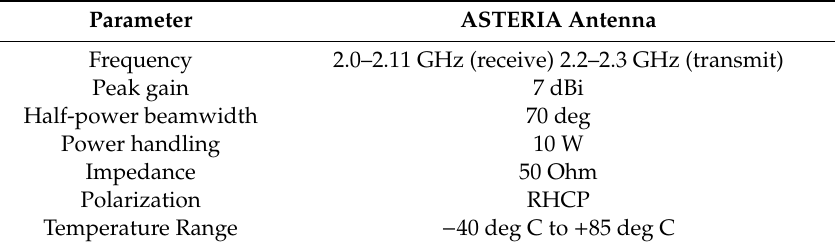
Figure 2. ASTERIA antenna, courtesy of Vulcan Wireless Inc. Table 1. ASTERIA antenna’s characteristics.